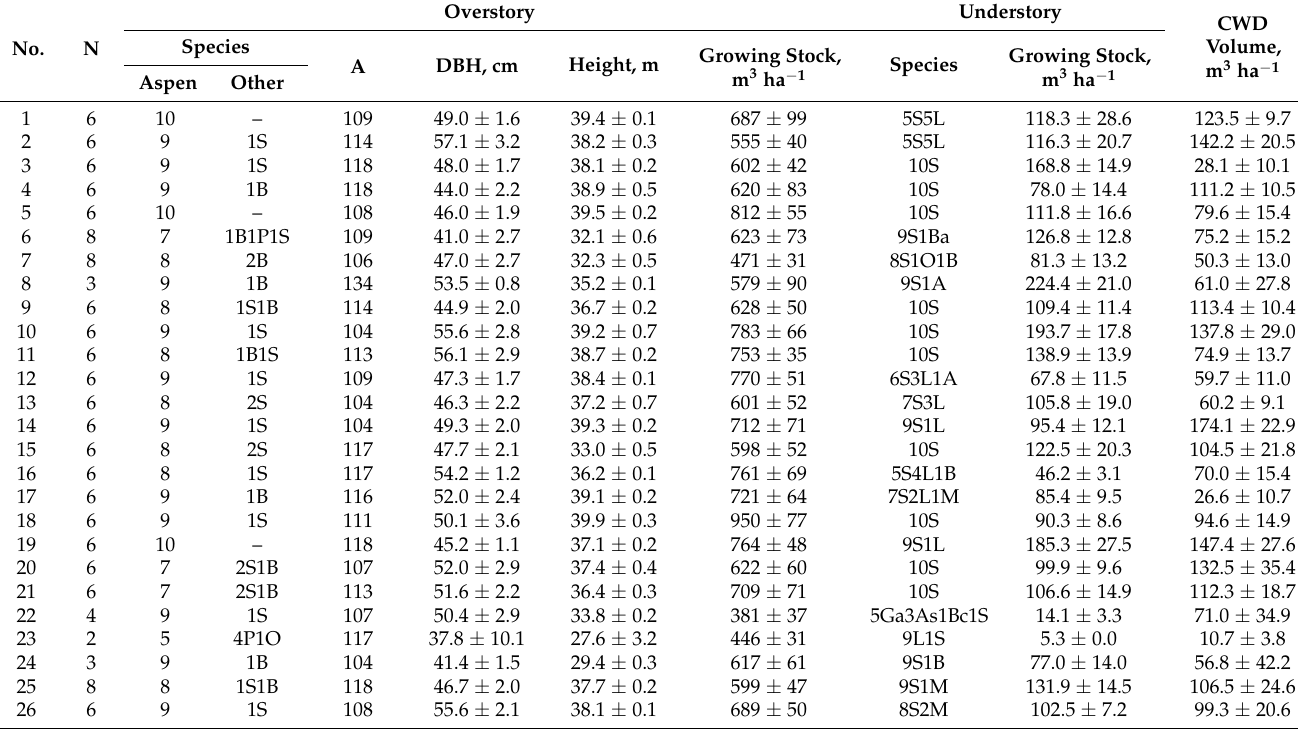
Table 1. Characteristics (marginal mean ± standard error) of old-growth European aspen ( Populus tremula L.) stands.